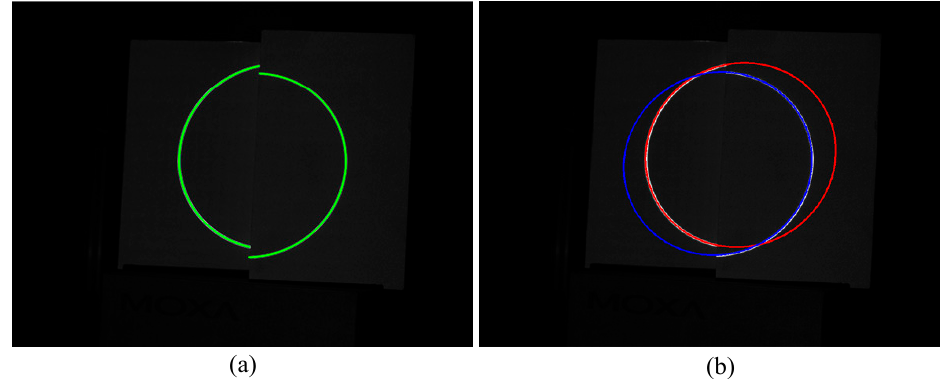
Figure 12. Result of processing the light stripes in the image. ( a ) Extraction of the center of the light stripes; ( b ) Ellipses obtained by ellipse fitting.